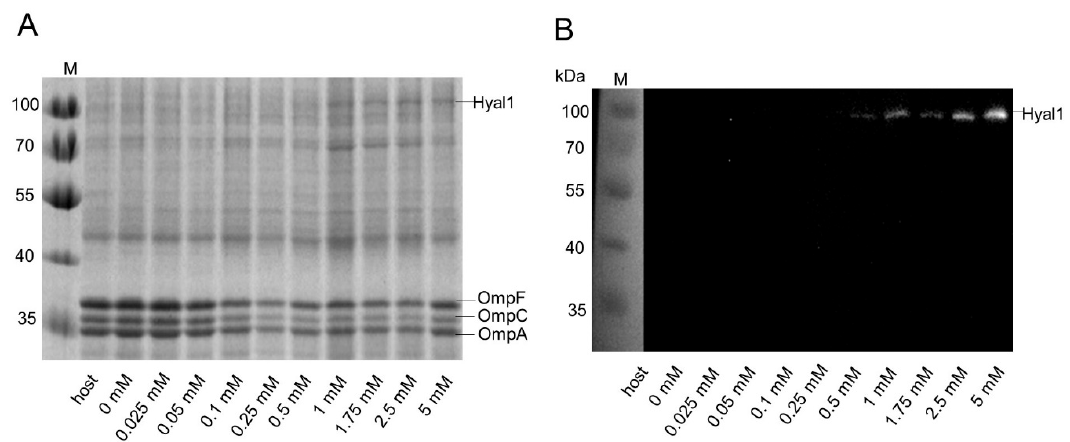
Figure 6. Surface expression of Hyal1 on E. coli F470, dependent upon inducer concentration. Outer membrane proteins of E. coli F470 (host) and E. coli F470 carrying pAIDAI rha -Hyal1 with and without (0 mM rhamnose) induction of Hyal1 protein expression were analyzed by 10% SDS-PAGE stained with ProBlue Safe Stain ® ( A ) and Western Blot analysis using a primary monoclonal anti-Hyal1 antibody and a secondary HRP-conjugated polyclonal antiserum ( B ). Apparent molecular weights are indicated on the left in kDa (M). Proteins samples were standardized by the amount of natural outer membrane proteins occurring, i.e., to show identical band size for OmpC, OmpF and OmpA. Rhamnose concentrations for induction of protein expression are given below the lanes of the gel and the western blot. Hyal1 and natural outer membrane proteins OmpF, C, and A are indicated.